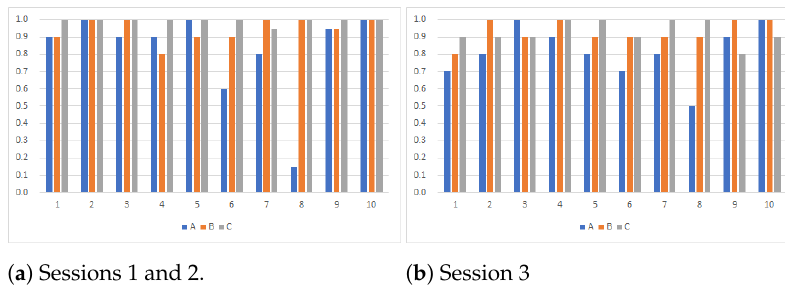
Figure 4. Frequency of actions consistent with the SPNE in